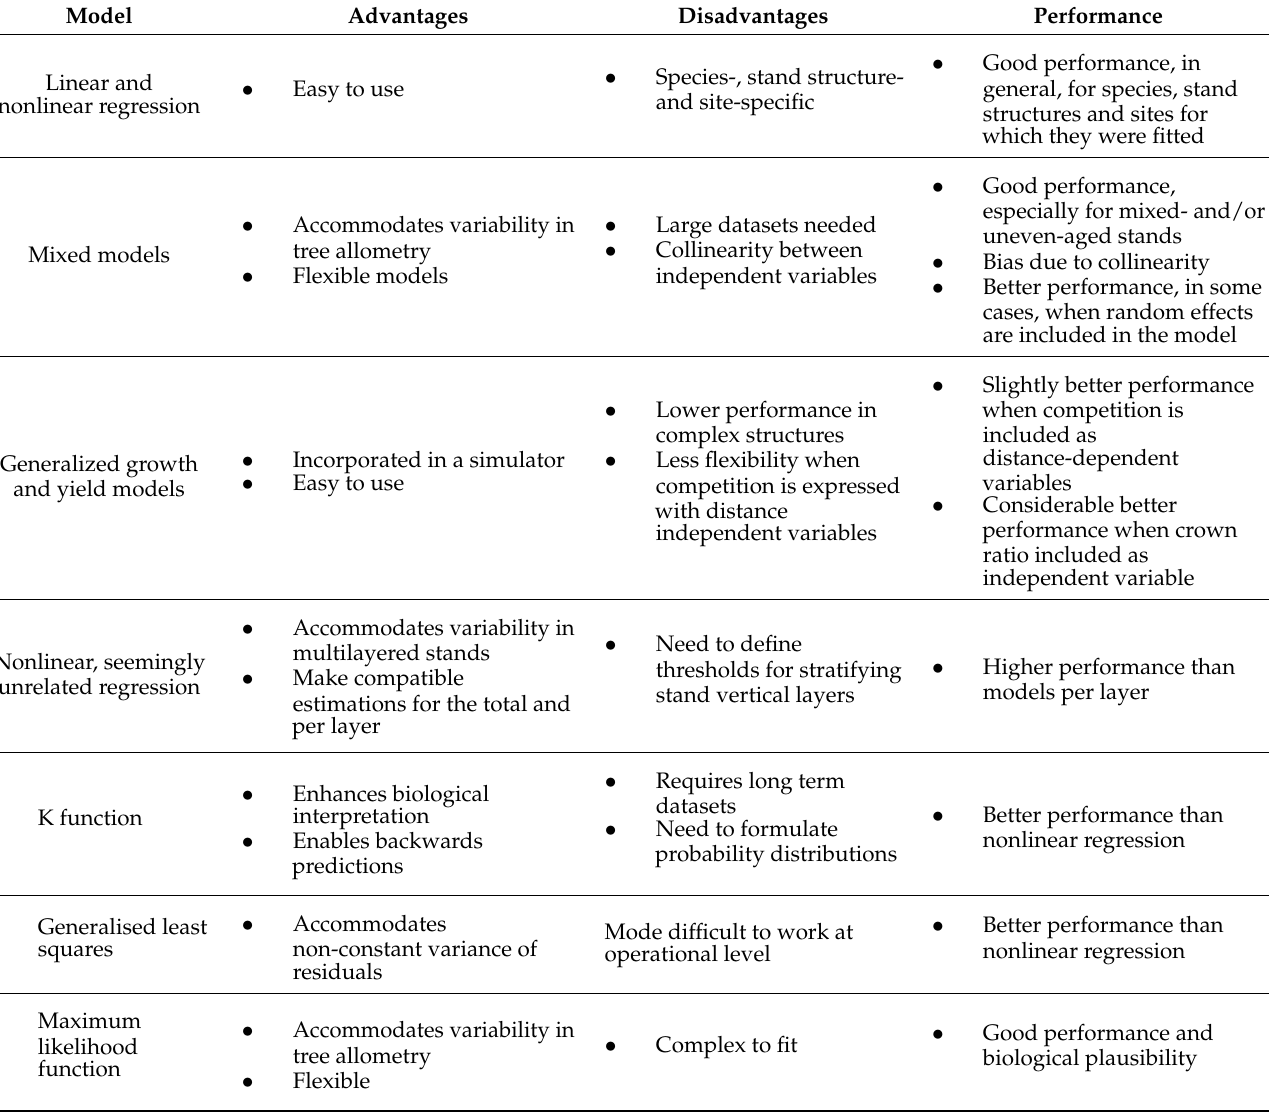
Table 1. Methods, advantages, disadvantages and performance of models to estimate diameter, height and